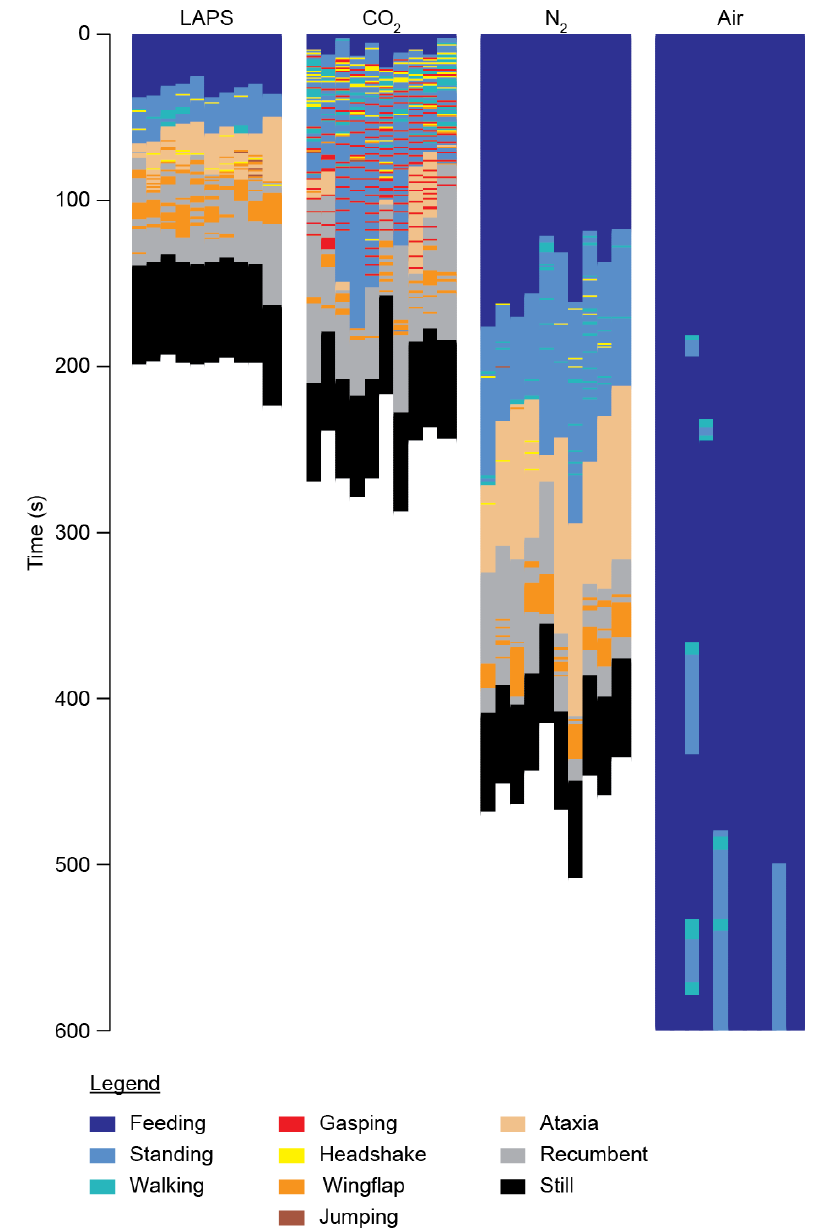
Figure 2. Grouped behavioural plots of all bird undergoing CAS.The graphical plots show the behaviours of the birds in 1 s bins categorised by treatment group. Colour coding for each behaviour is shown in the legend at the bottom. Note that “Still” (black) shows the 60 s observation period following cessation of all observable movement, including breathing, before the termination of experiments.